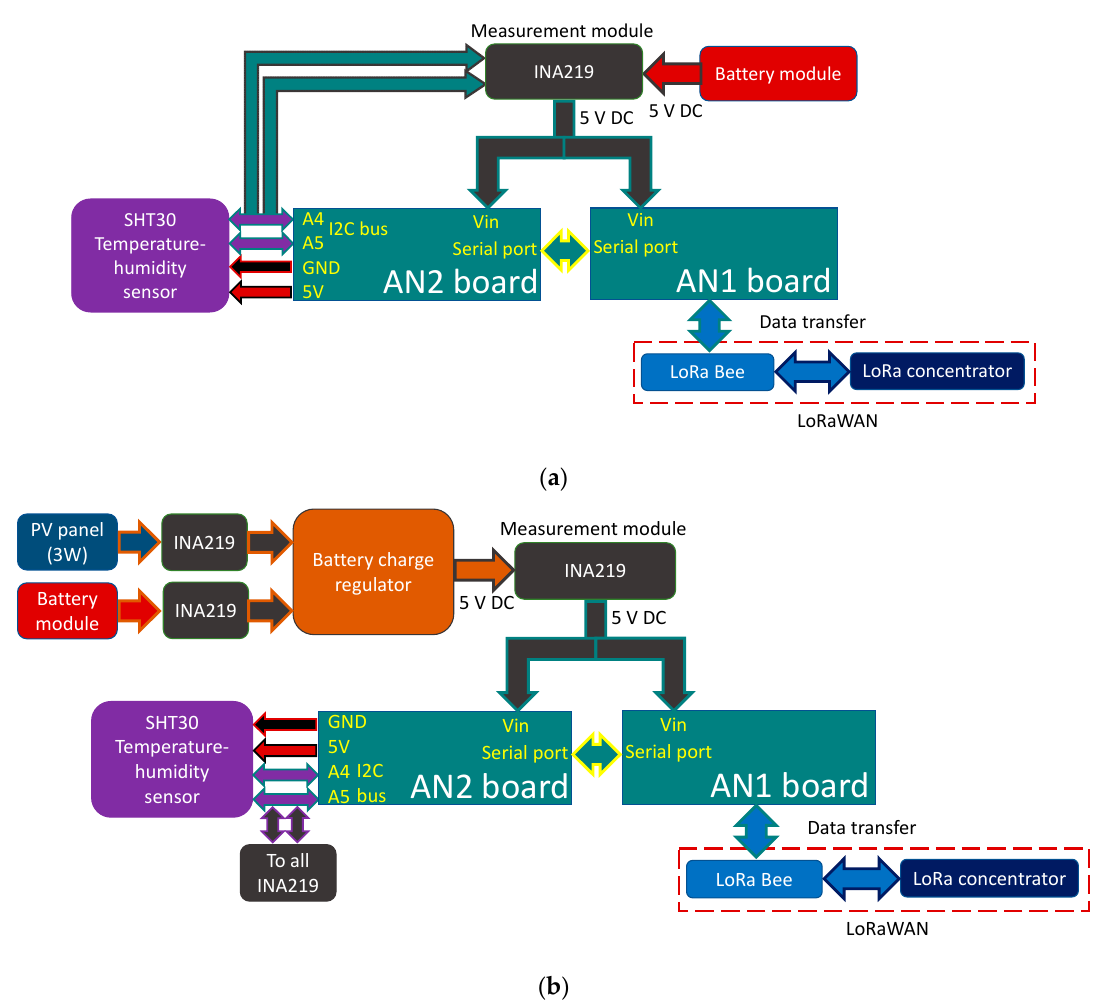
Figure 2. Block diagram of the THMDL: ( a ) battery power supply and ( b ) battery and solar panel power supply.